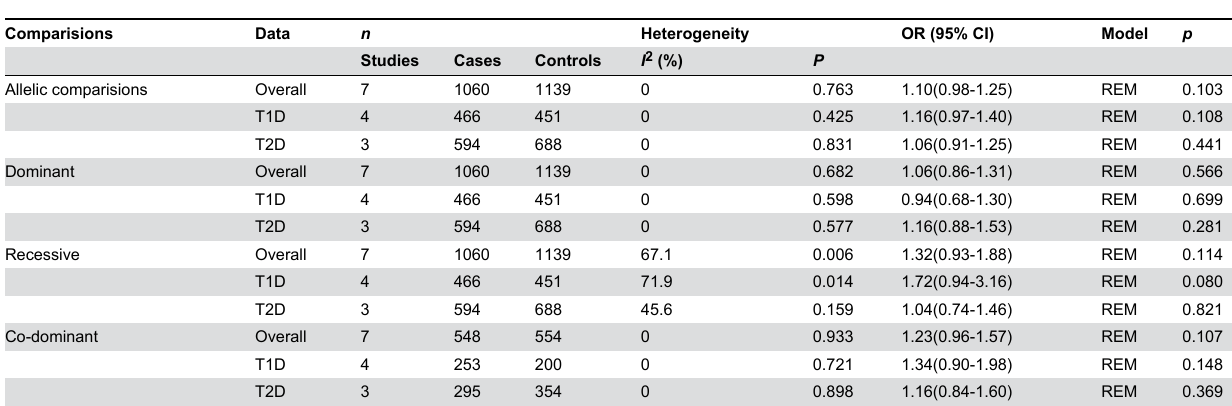
Table 3. Pooled measures for the association between the PAI-1 -675 4G/5G polymorphism and susceptibility to diabetic